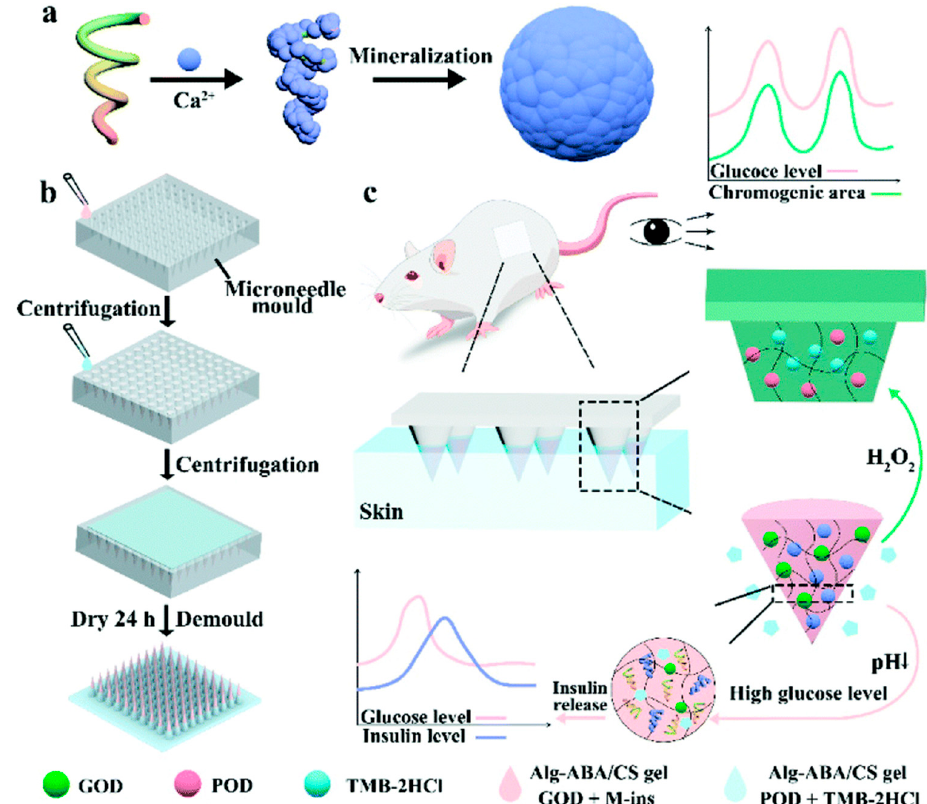
Figure 12. Schematic diagram of glucose responsiveness that triggers the self-adjustable release of insulin and perception of blood glucose in real-time. ( a ) Insulin mineralization under Ca 2+ . ( b ) Dual- functional MN prepared by cross-linking and micro-molding. ( c ) Self-regulated release of insulin is triggered by glucose responsiveness and real-time glucose sensing [108]. Reproduced with permission from Xuetong Sun, Biomaterials Science; published by The Royal Society of Chemistry, 2022.